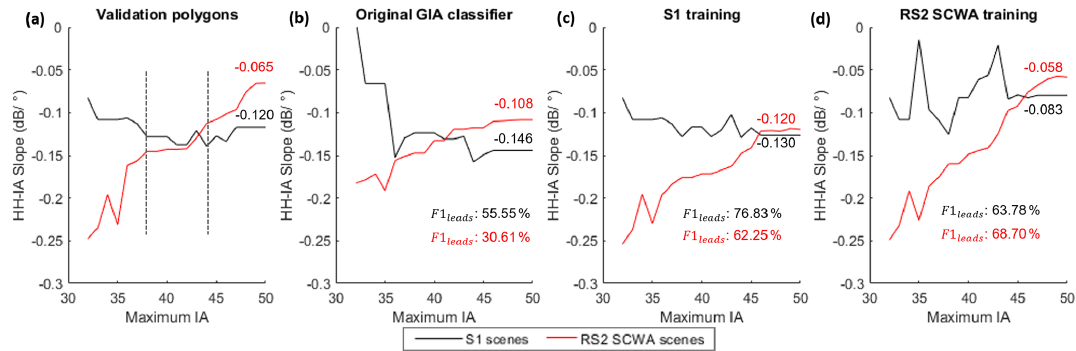
Figure 8. HH–IA slopes for different IA maximums and F1 scores of the leads class, with the overall slopes (maximum IA = 50) shown in corresponding colors (black: S1 scenes; red: RS2 SCWA scenes).